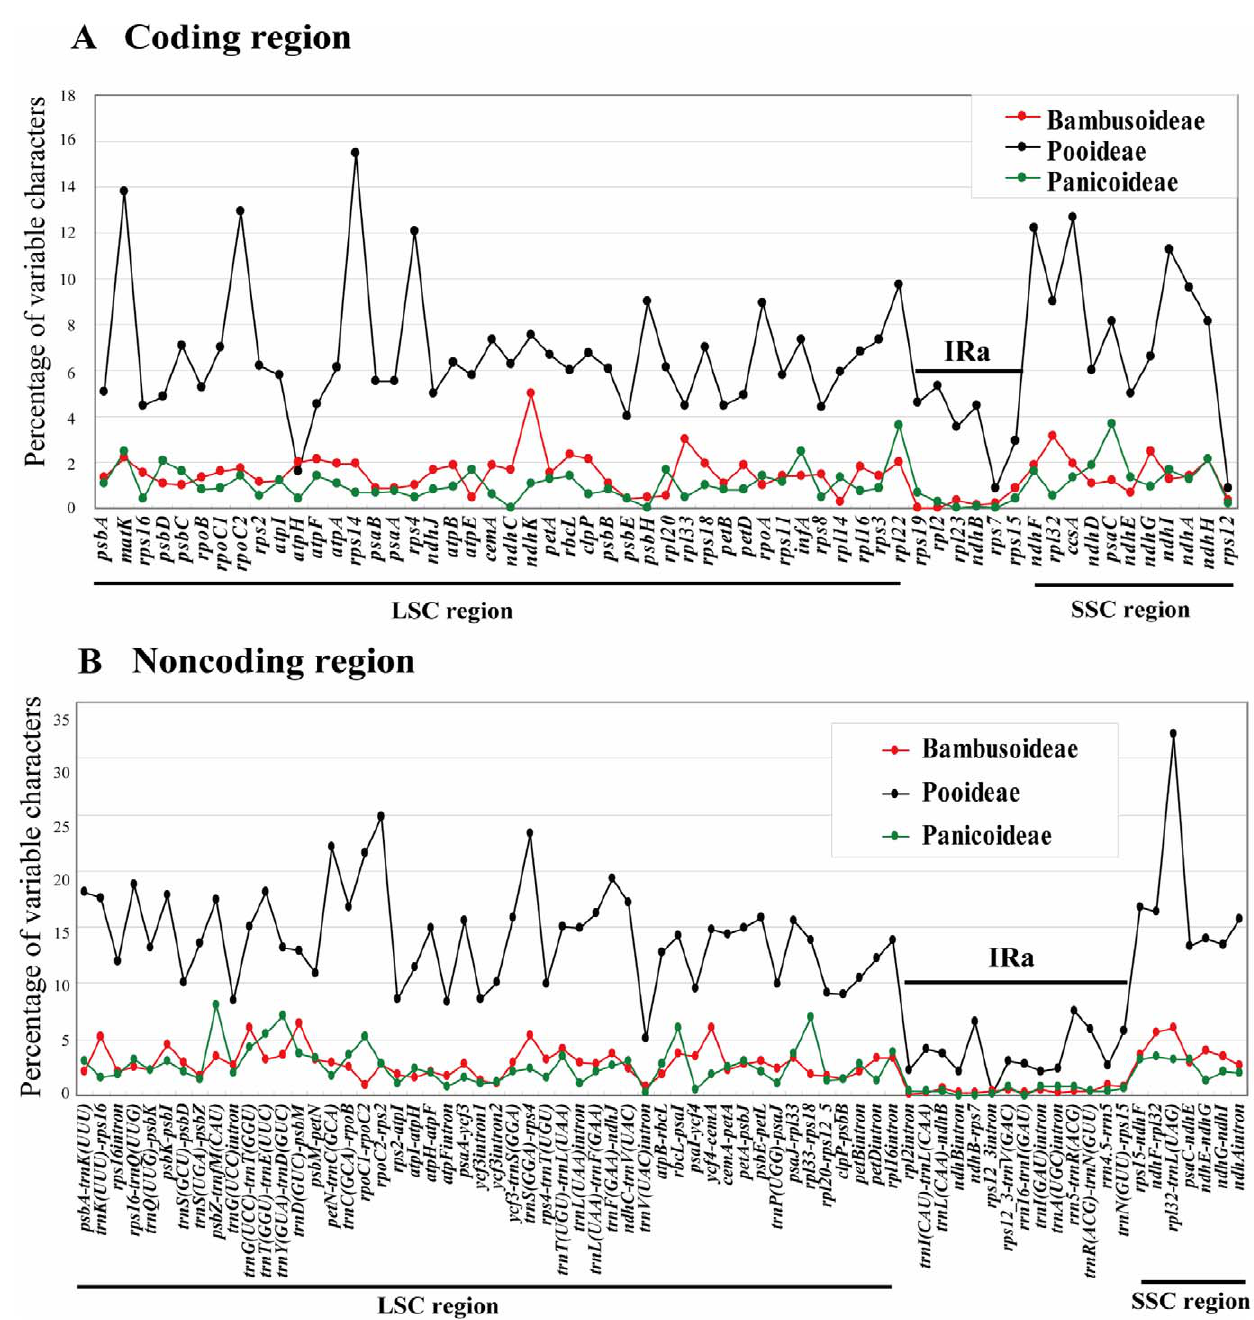
Figure 8. Percentage of variable characters in homologous regions among chloroplast genomes of Panicoideae, Pooideae and Bambusoideae. A ) Coding region. B ) Noncoding region. The homologous regions are oriented according to their locations in the chloroplast genome.